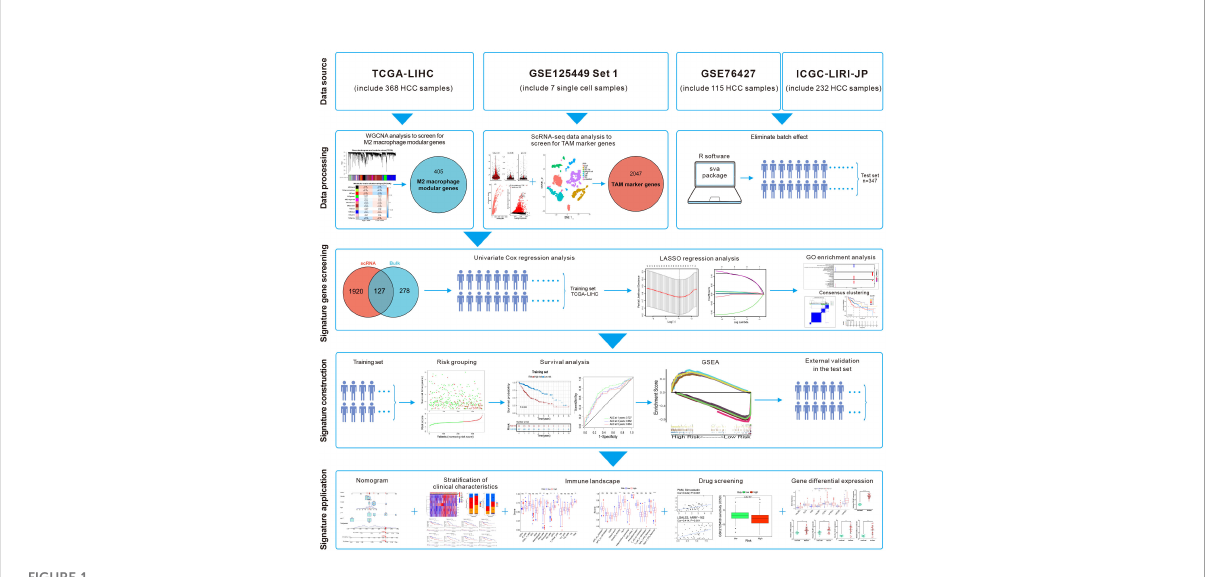
FIGURE 1 Flowchart of this